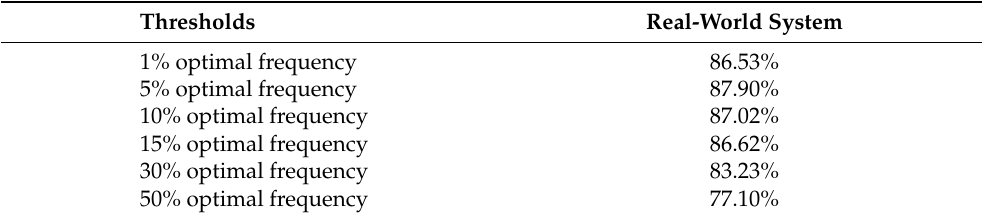
Table 6. Accuracy of rule-based anomaly detection for utility function input under different